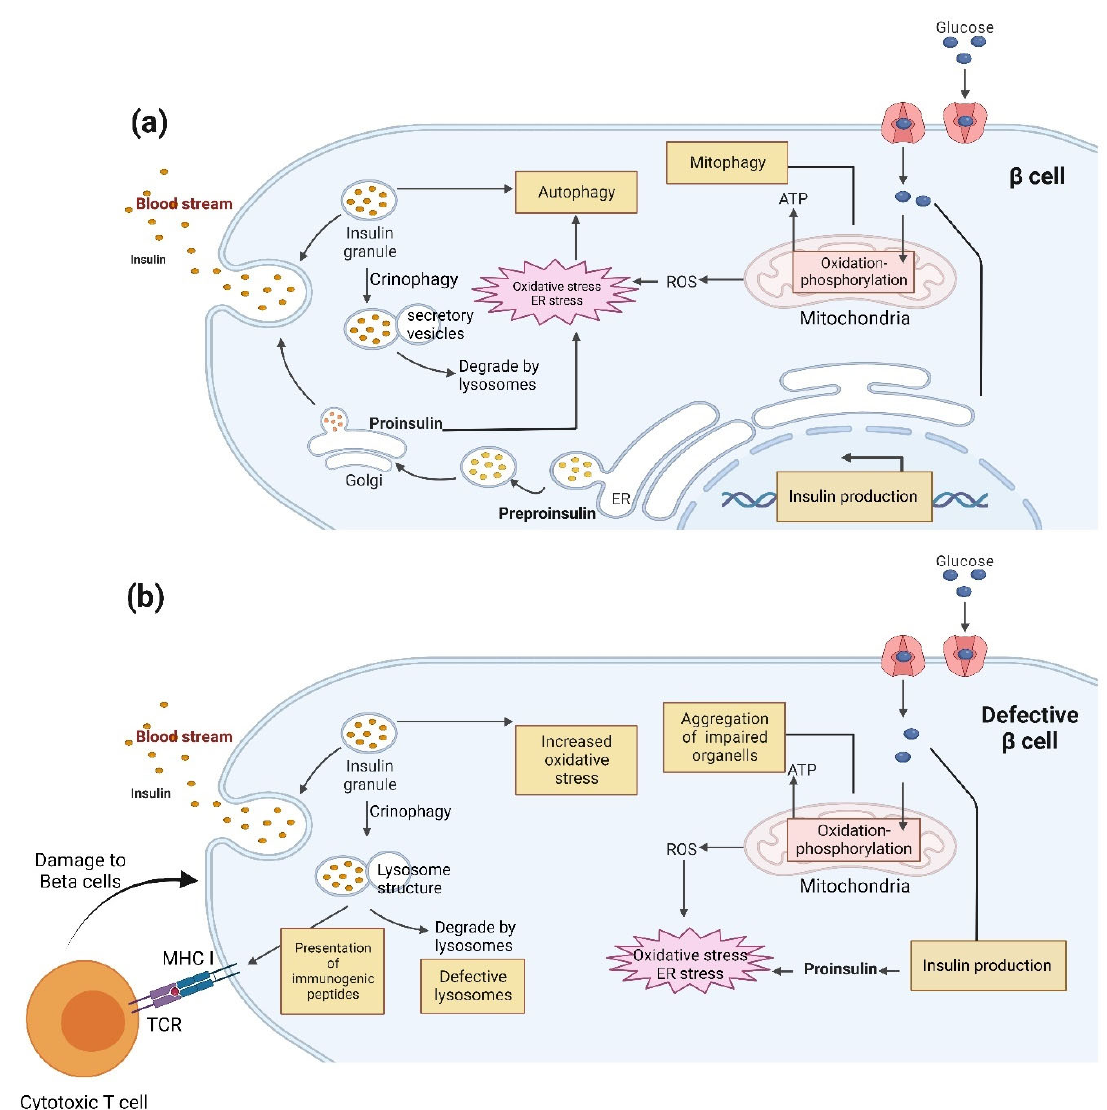
Figure 5. The possible role of autophagy (crinophagy) in insulin production, physiological conditions, and the pathological onset of T1D. ( a ) Glucose metabolism in the mitochondria generates ATP and ROS, which are two important insulin production and secretion